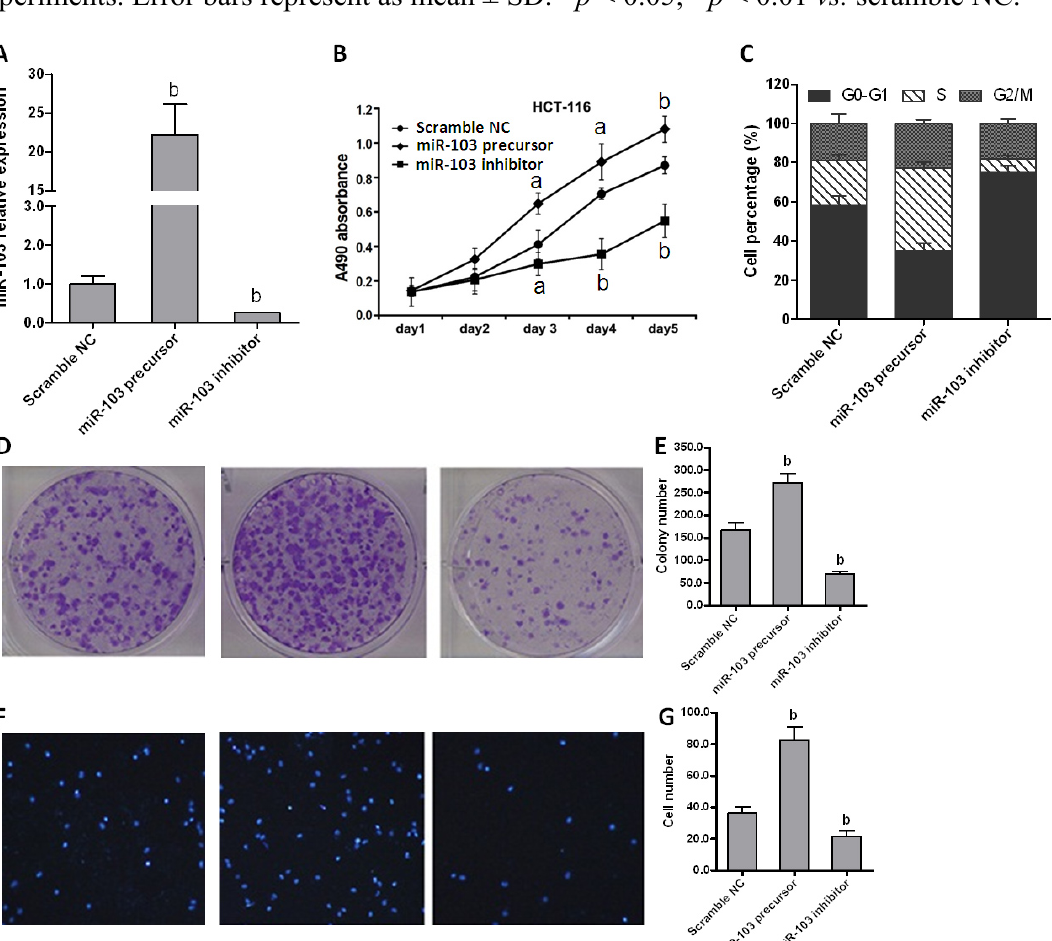
Figure 2. miR-103 affects colorectal carcinoma cell proliferation and cell cycle in vitro . ( A ) Expression of miR-103 in HCT-116 cells transfected with scramble negative control (NC), miR-103 precursor or inhibitor was quantified by real-time PCR; ( B ) Proliferation rates of HCT-116 cells were detected by 3-(4,5-dimethylthiazol-2-yl)-2,5-diphenyltetrazolium bromide (MTT) assay; ( C ) Cell cycle distributions of HCT-116 cells were analyzed by flow cytometry; ( D ) HCT-116 cells were cultured for 10 days after transfection and cell viability was analyzed by colony formation assay; ( E ) analysis results of D ; ( F ) Transwell assay was used to detect cell migration (40× magnification). Data are representative of three experiments; and ( G ) analysis results of F . Data are representative of three experiments. Error bars represent as mean ± SD. a p < 0.05; b p < 0.01 vs. scramble